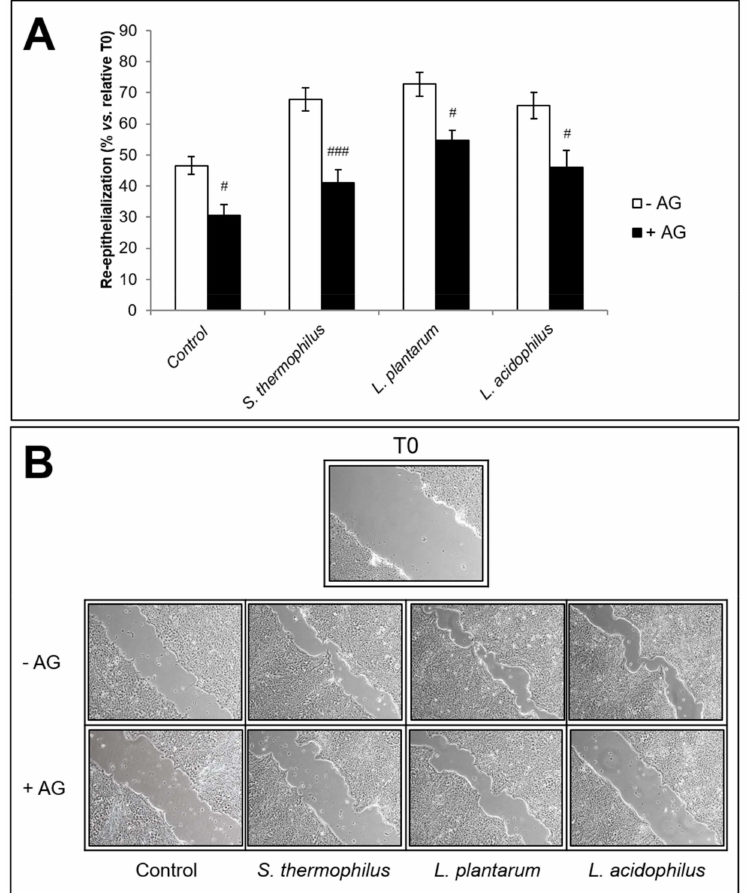
Figure 4. E ff ect of NOS2 inhibitor AG on the re-epithelialization of HaCaT scratched monolayers induced by S. thermophilus , L. plantarum , and L. acidophilus . ( A ) E ff ect of 15 min pre-treatment with 20 µ M AG on the relative wound closure rate (%) of scratched monolayers with or without the indicated probiotic lysate-soluble fraction at 50 µ g / mL for 20 h. Data are expressed as mean ± SEM of three independent experiments in duplicate. For comparative analysis of groups of data, a two-way analysis of variance (ANOVA) with post hoc Bonferroni test was used. # p < 0.05, ### p < 0.001 vs. each relative culture without AG. ( B ) Representative images of HaCaT cell line scratched monolayers pre-treated with or without 20 µ M AG for 15 min and then with S. thermophilus, L. plantarum or L. acidophilus samples at 50 µ g / mL for 20 h (10 ×